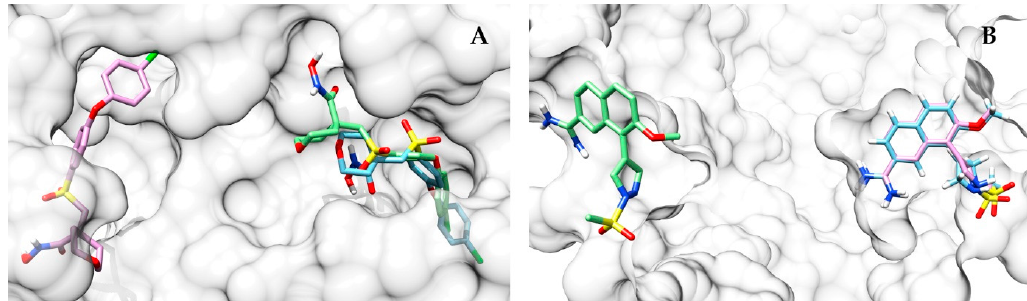
Figure 9. Comparison of the top scoring prediction of CS (green) and AutoDock Vina (pink) with respect to the co-crystallized ligand (light blue). In A, the binding site of mmp13 (PDB: 830C) is depicted. It can be observed that CS predicts a near-native pose as top scoring, while AutoDock Vina places its top scoring pose far away from the binding pocket. The opposite scenario can be observed in panel B in the binding site of urok (PDB: 1SQT).